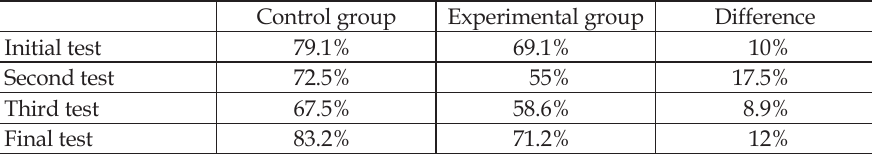
Tab. 1. Results of the tests and the difference between the control and the experimental group Control group Experimental group